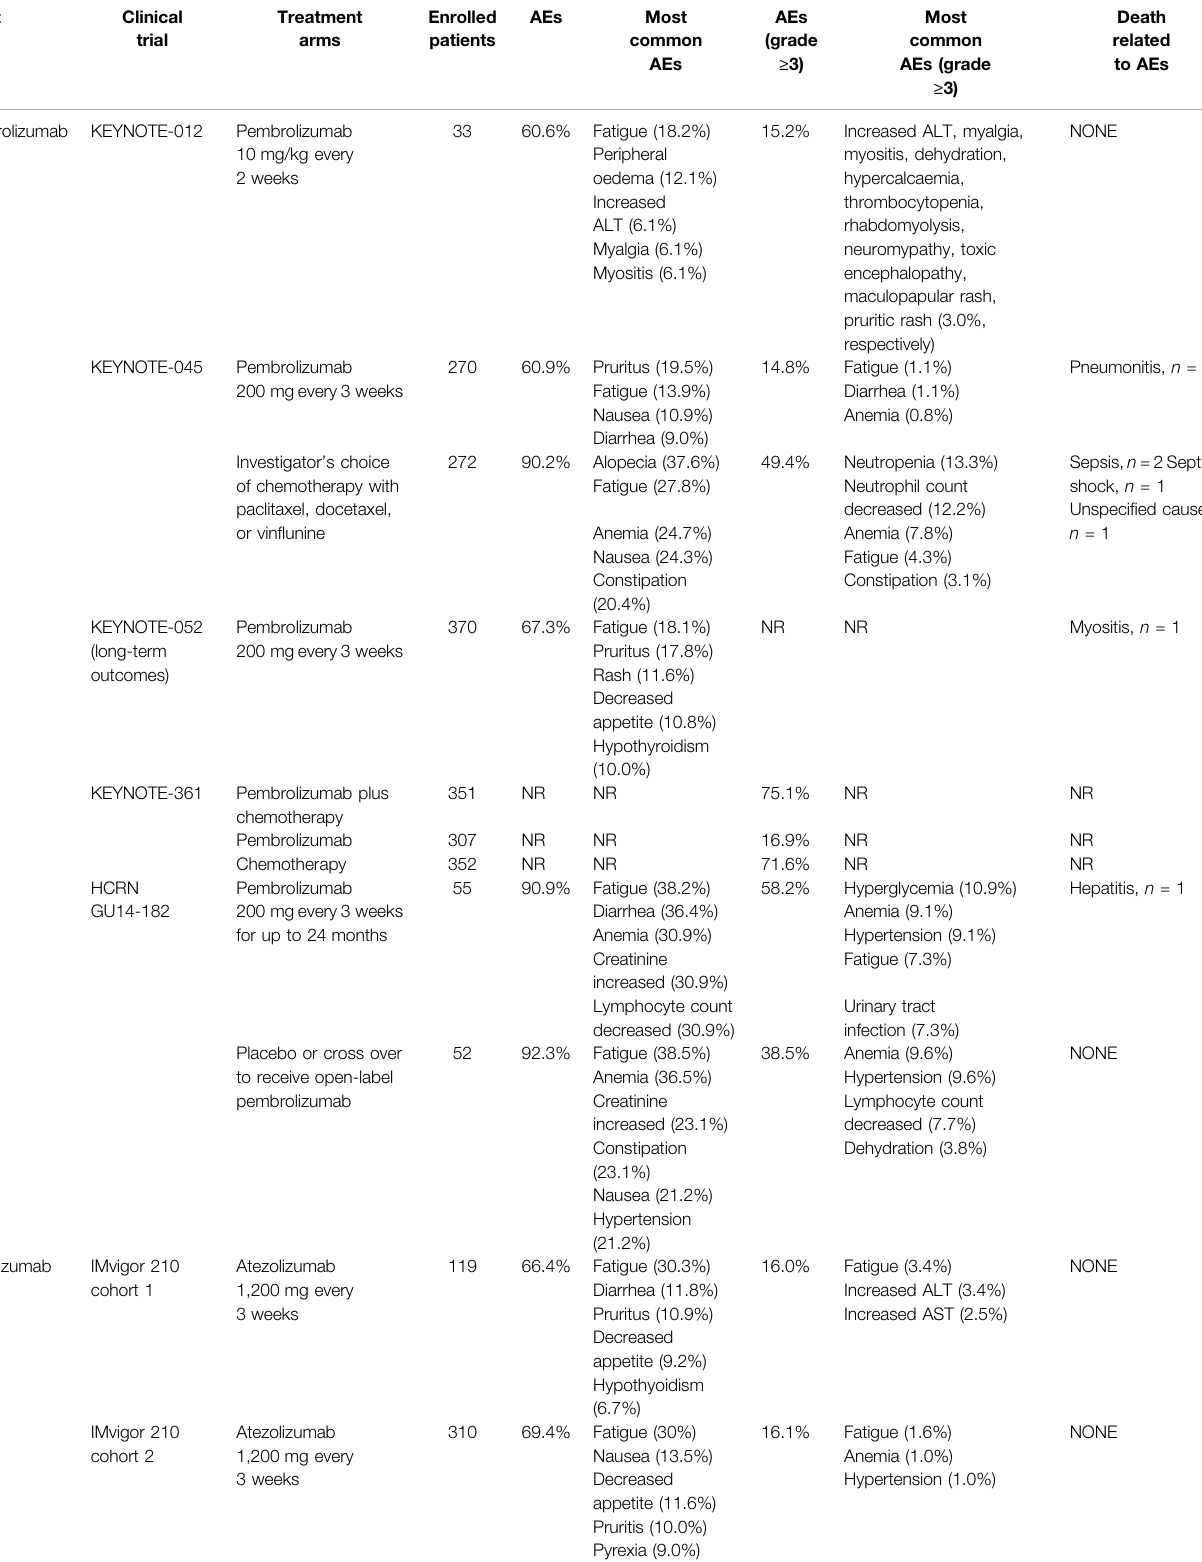
TABLE 3 | Key clinical trials ’ safety data of ICIs in patients with